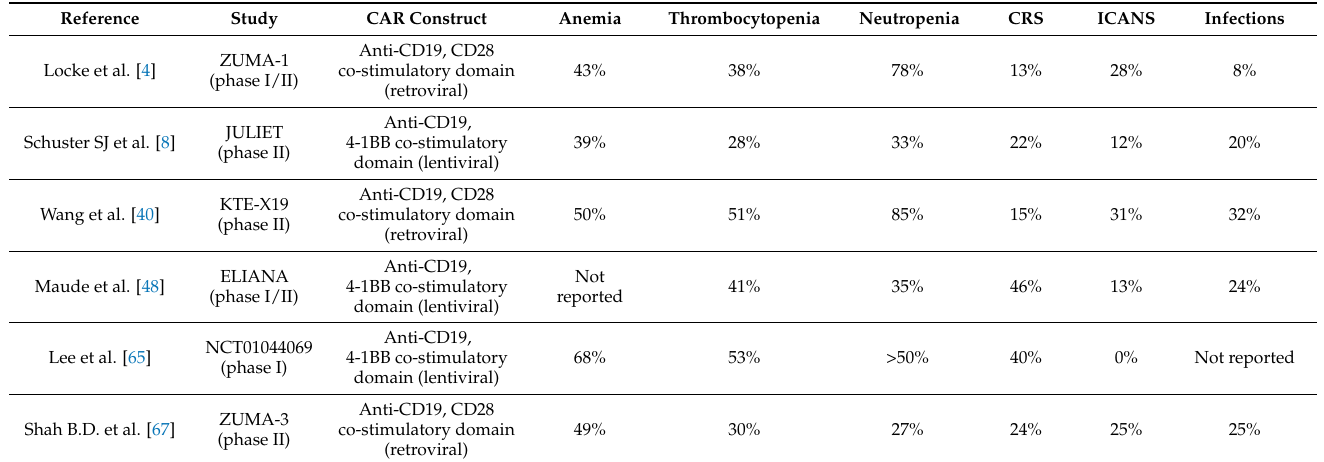
Table 2. Clinical Studies and >Grade 2